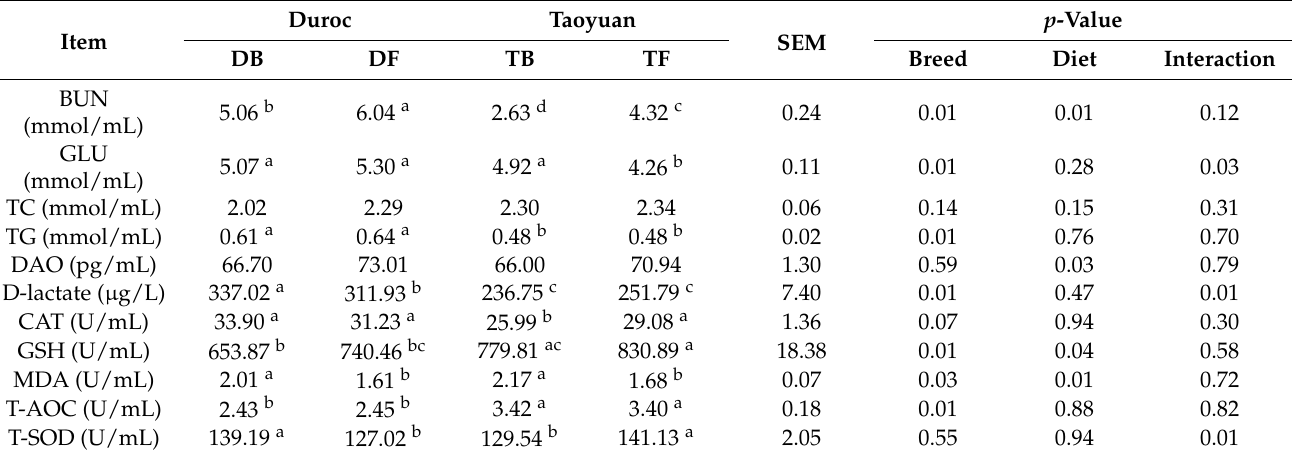
Table 3. Effects of DF on serum biochemical